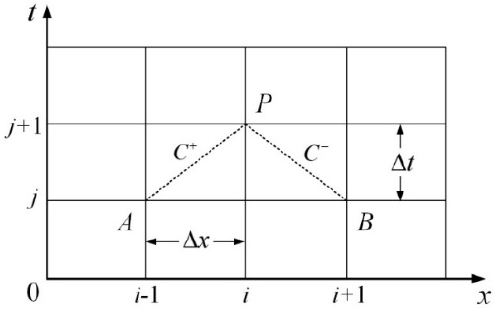
Figure 1. Characteristics lines in the x ‐ t plane.